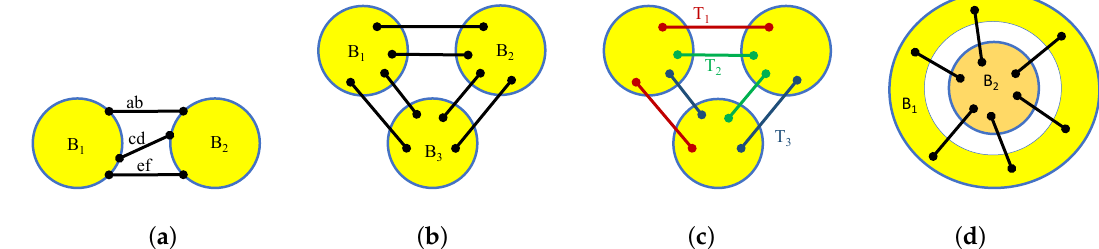
Figure 42. Some examples of isostatic body-bar frameworks in P 2 ( a , b ) and in P 3 ( d ). Figure ( c ) illustrates the 3 edge-disjoint spanning trees in ( b ) guaranteed by Theorem 16.